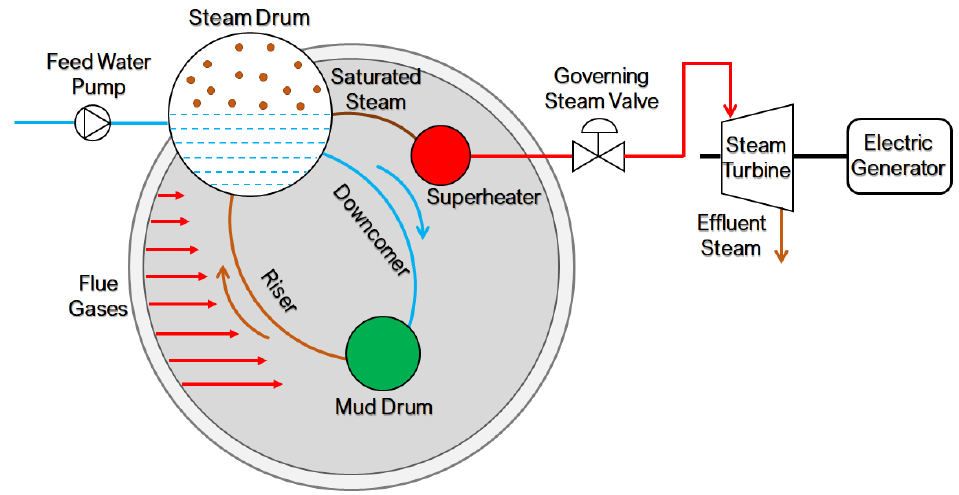
Figure 2. Drum boiler system